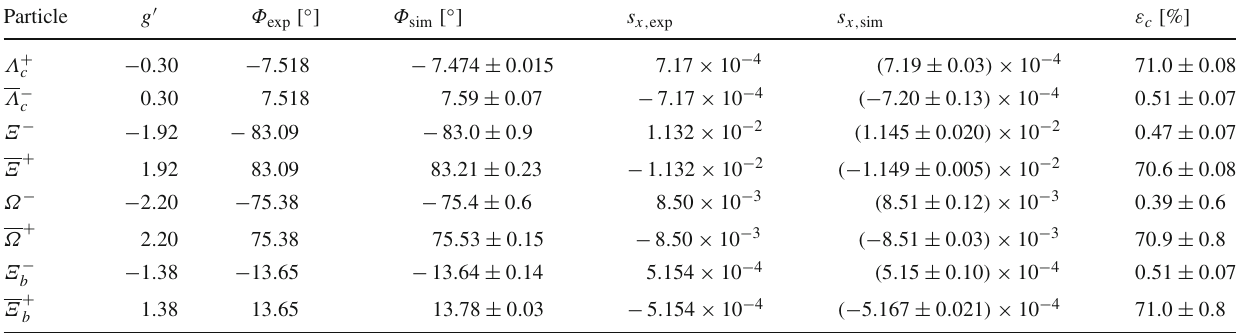
factor d = 5 × 10 − 2 , along with the mean channeling deflection effi- ciency ( ε c ), for different 1TeV / c particles impinging on a 1cm long Si crystal bent along the ( 110 ) plane at 1mrad angle. The normalization of the polarization vector s 0 has been taken unity, i.e. s 0 =